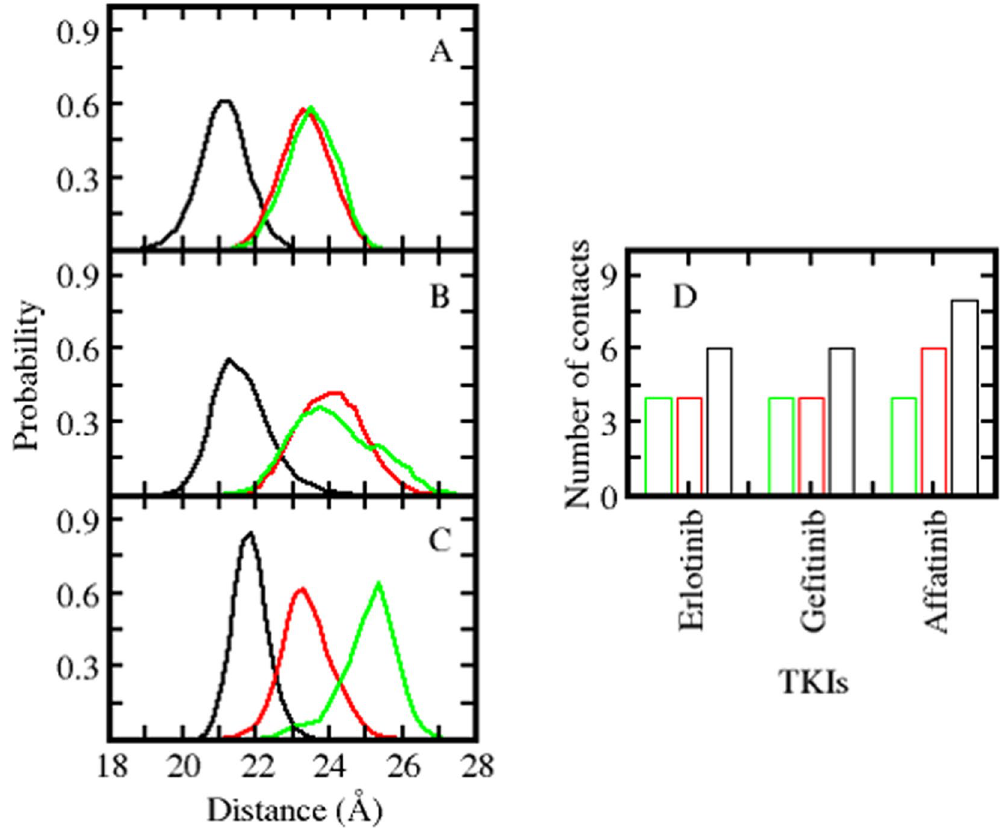
Figure 3. Distribution of ligand binding pocket size. Distances between α C-helix and binding site of conformations sampled during the MD simulations of EGFR WT (green), EGFR L858R (red) and EGFR 19del (black) complexed to ( A ) afatinib ( B ) gefitinib ( C ) erlotinib state. ( D ) Average number of contacts that various inhibitors make with the alpha C-helix of EGFR WT (green), EGFR L858R (red) and EGFR 19del